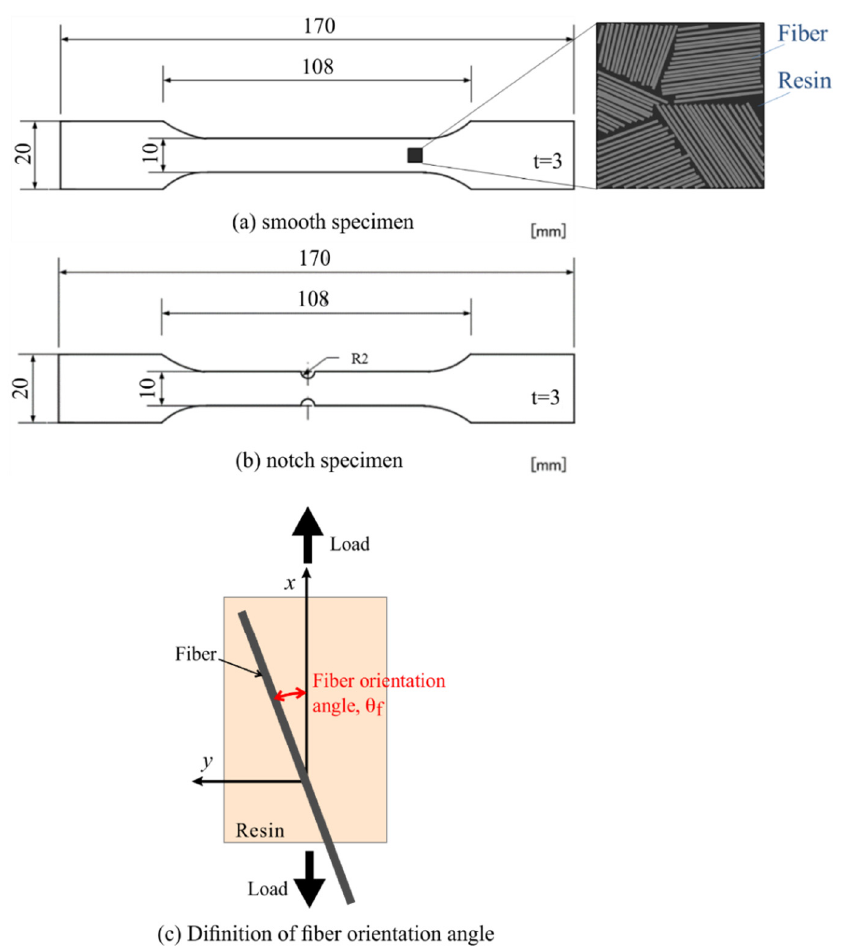
Figure 2. Configurations of the employed short carbon fiber reinforced plastic specimen.